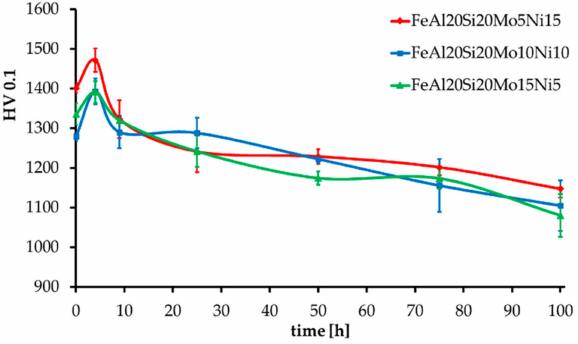
Figure 6. Thermal stability of the MA + SPS alloys expressed as HV 0.1 change during long-term annealing at 800 ◦ C.